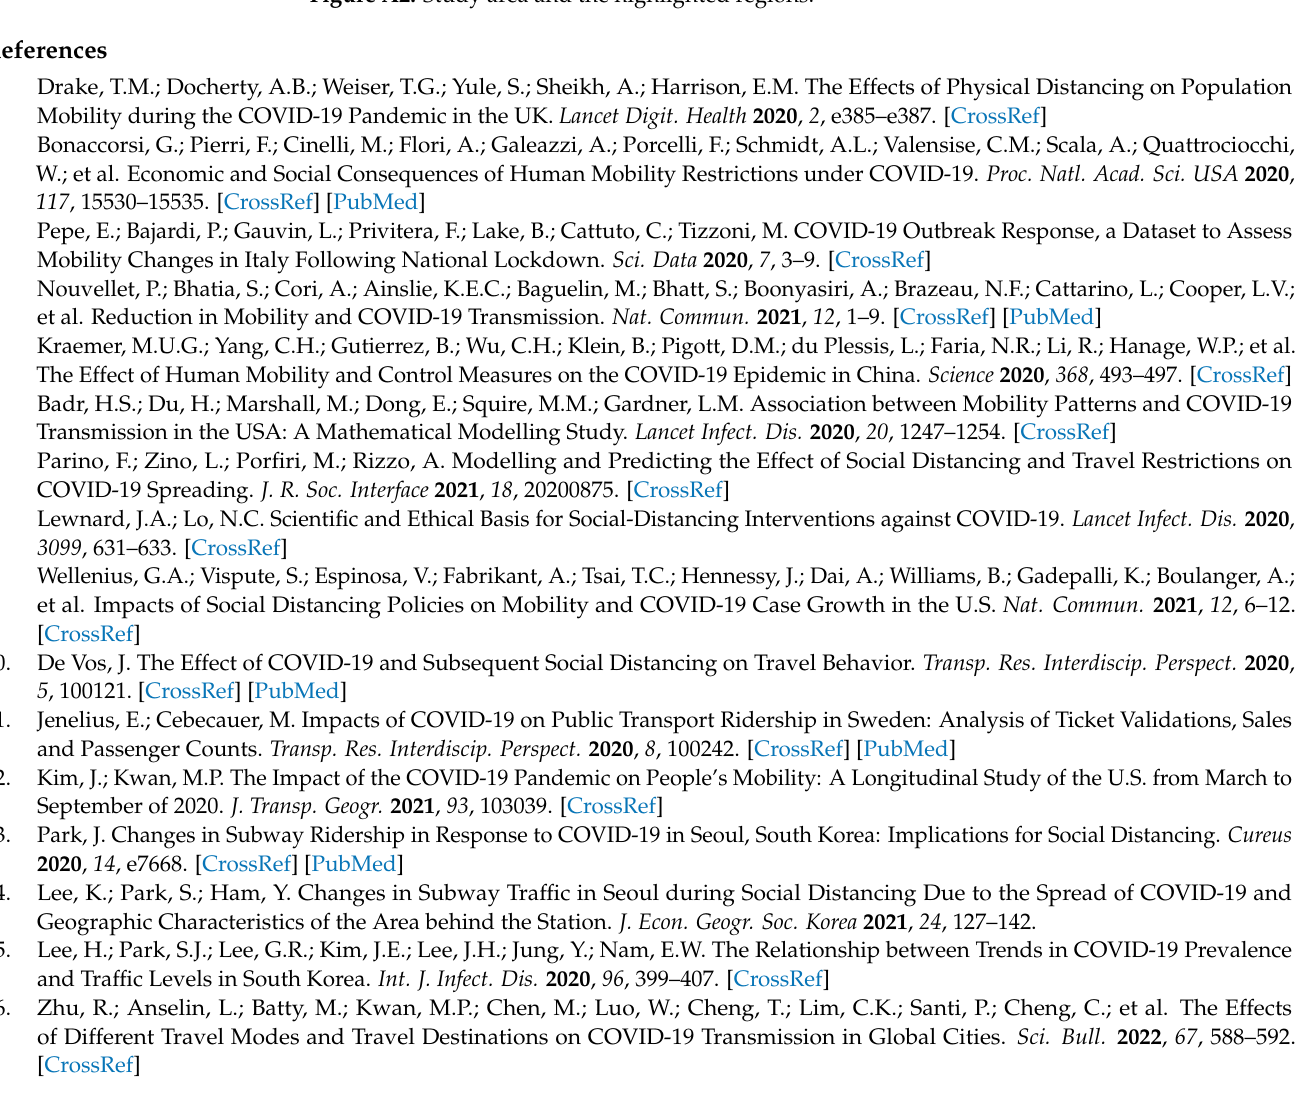
Figure A2. Study area and the highlighted regions.